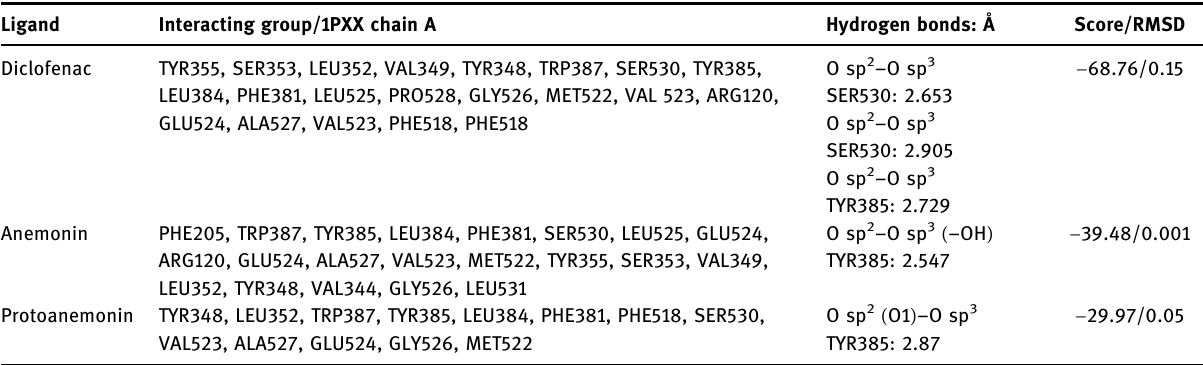
Table 2: Results of molecular docking study on cyclooxygenase 2, COX - 2